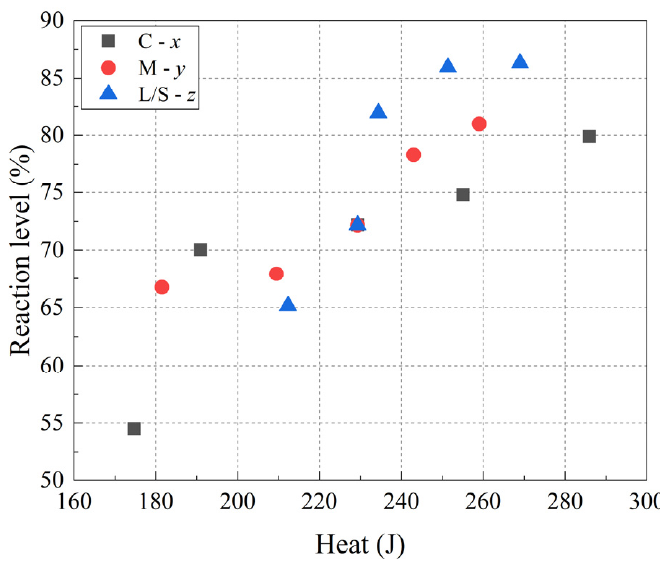
Figure 3. Reaction extent as a function of total heat released.